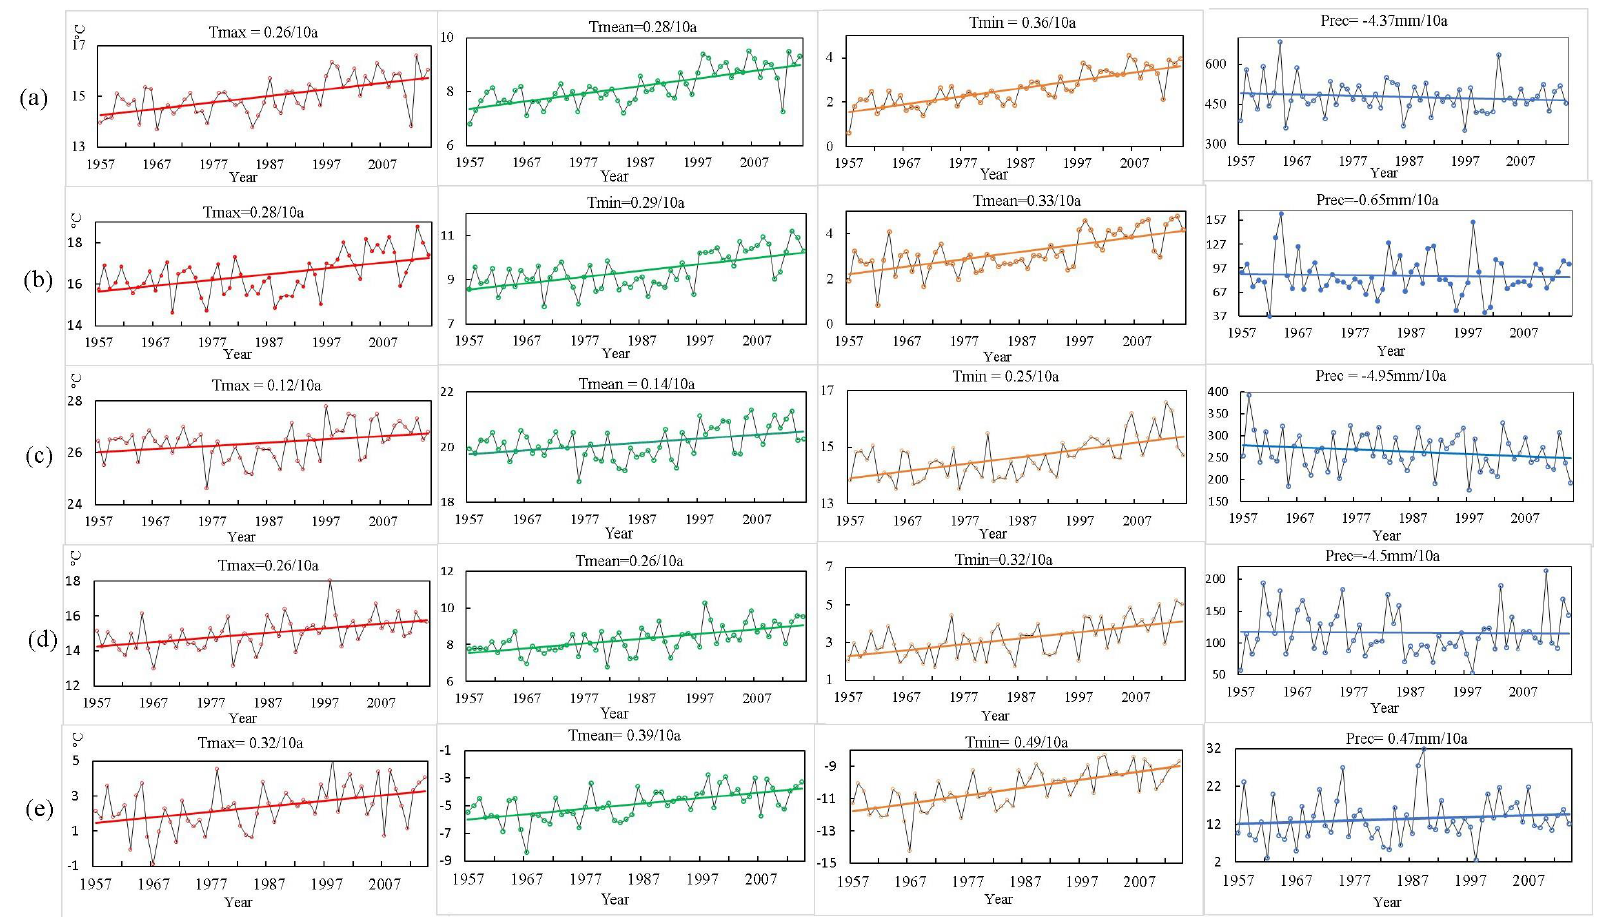
Figure 2. Annual and seasonal variability of hydrothermal climate variables in the Yellow River Basin from 1957 to 2015. These indices are obtained averaging each field over the Yellow River Basin. ( a ) Annual variability; ( b ) variability in the spring; ( c ) variability in the summer; ( d ) variability in the autumn; and ( e ) variability in the winter.